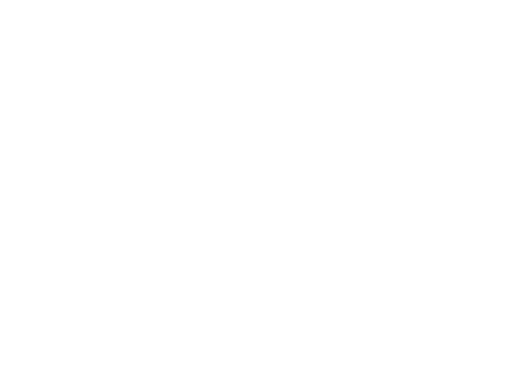
Figure 2. Plotted data for lumbar lordosis, thoracic kyphosis, RoF, RoE and RoM for each measurement device. ( a ) The measured lumbar lordosis (blue) and thoracic kyphosis (yellow) for each measurement device. ( b ) The range of flexion (RoF), extension (RoE) and range of motion (RoM) of the Idiag M360 and the Epionics SPINE. Significante differences are marked by asterisk.